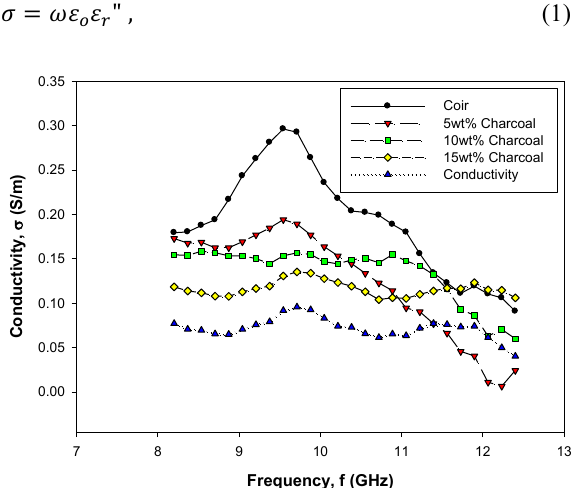
Figure 7: Conductivity of the five samples over x-band frequency